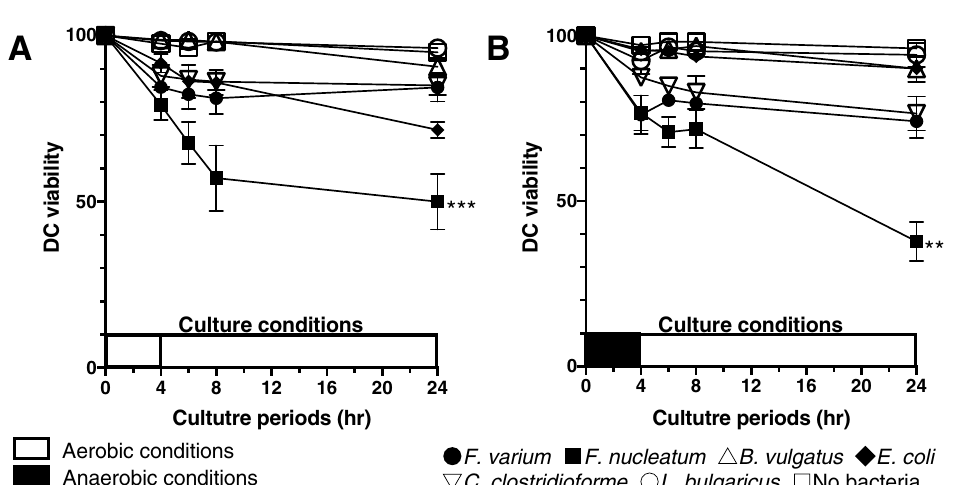
Figure 2. The viability of the DC line after coculture with live commensal bacteria under aerobic or anaerobic conditions. The DC line was cocultured with each live commensal bacteria for 4 h under aerobic ( A ; white square ) or anaerobic ( B ; black square ) conditions. After coincubation, the DC line was washed to remove commensal bacteria and further incubated for 2, 4, or 20 h under aerobic (white square ) conditions (total of 6, 8, or 24 h). Then, the percentage of viable cells was assessed at various culture periods. The results are presented as the means ± SD from three independent experiments. ** p < 0.01 and *** p < 0.001 compared to the control unstimulated DC line.